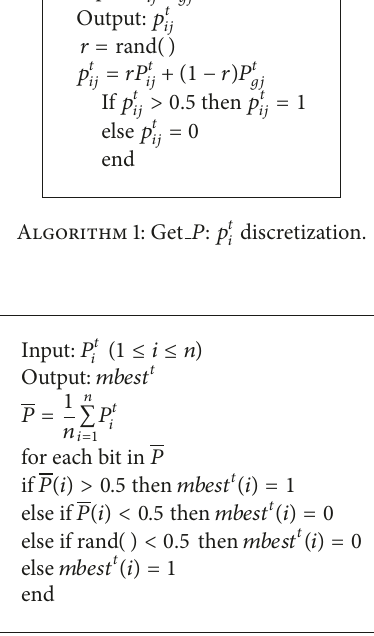
Algorithm 2: Get 𝑚𝑏𝑒𝑠𝑡 : 𝑚𝑏𝑒𝑠𝑡 𝑡